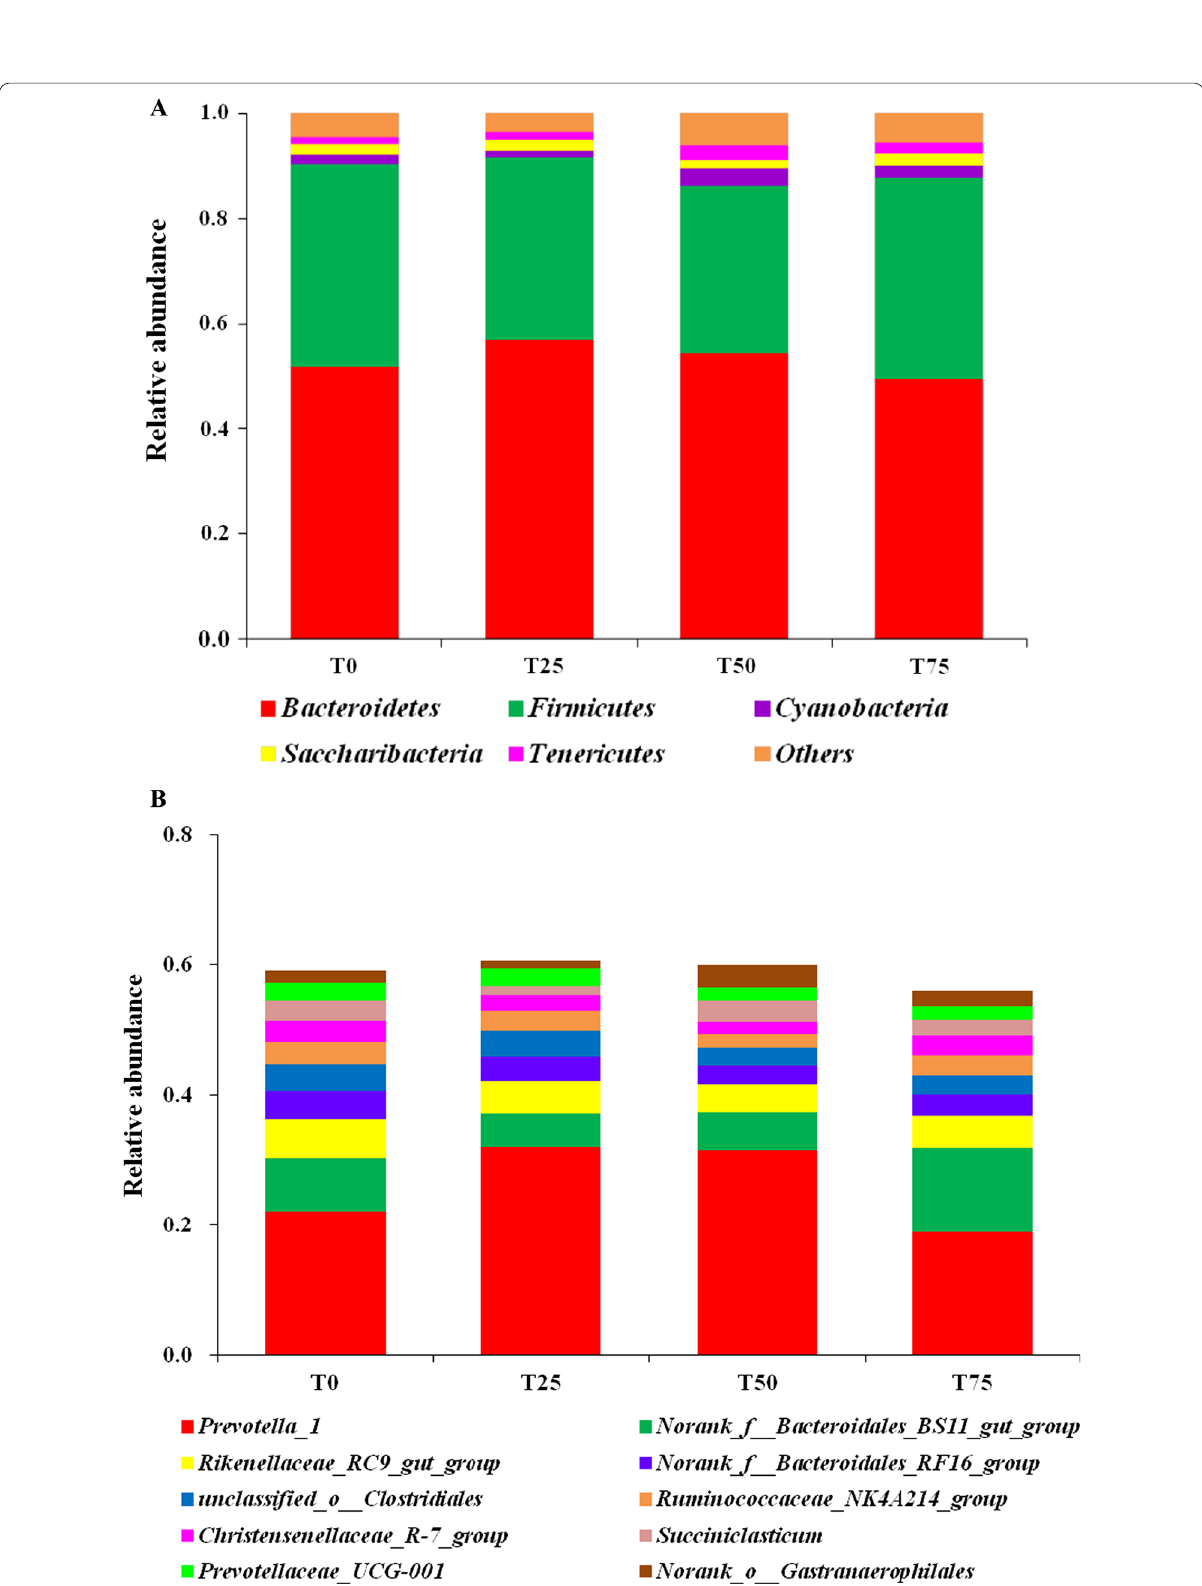
Fig. 2 Effect of B. papyrifera silage on rumen microbiota composition. The rumen micobiota composition of Holstein heifers in T0, T25, T50 and T75 group at A phylum and B genus